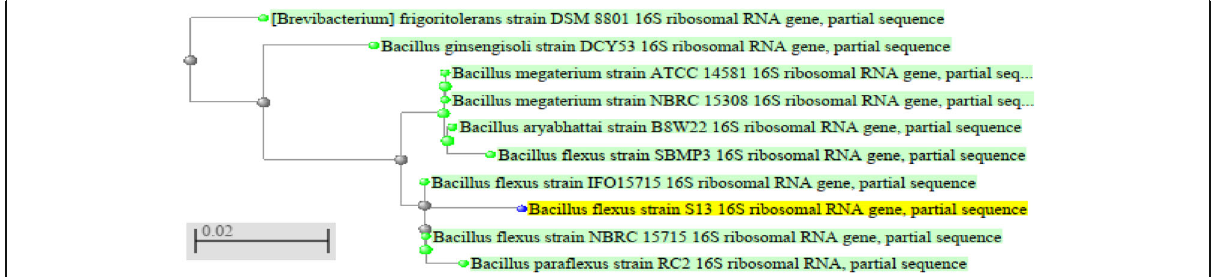
Fig. 5 Phylogenetic tree analysis of Bacillus flexus